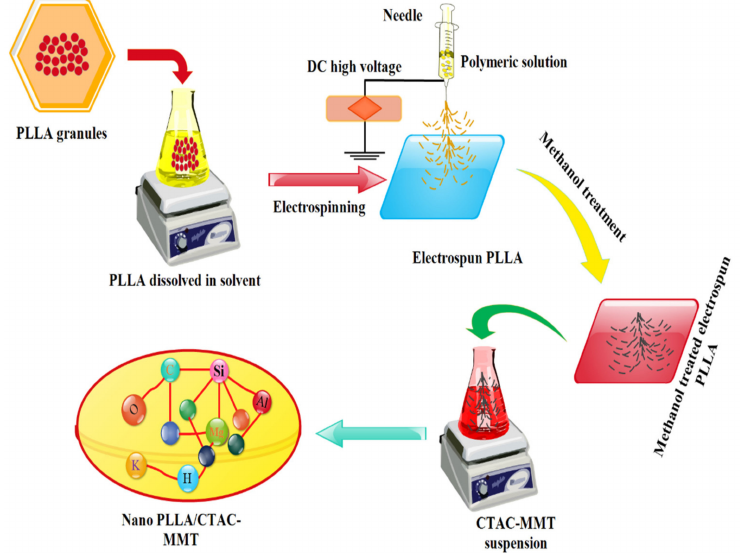
Figure 2. Preparation process flow of PLA / CTAC-MMT composites to follow of electrospinning and dip-coating